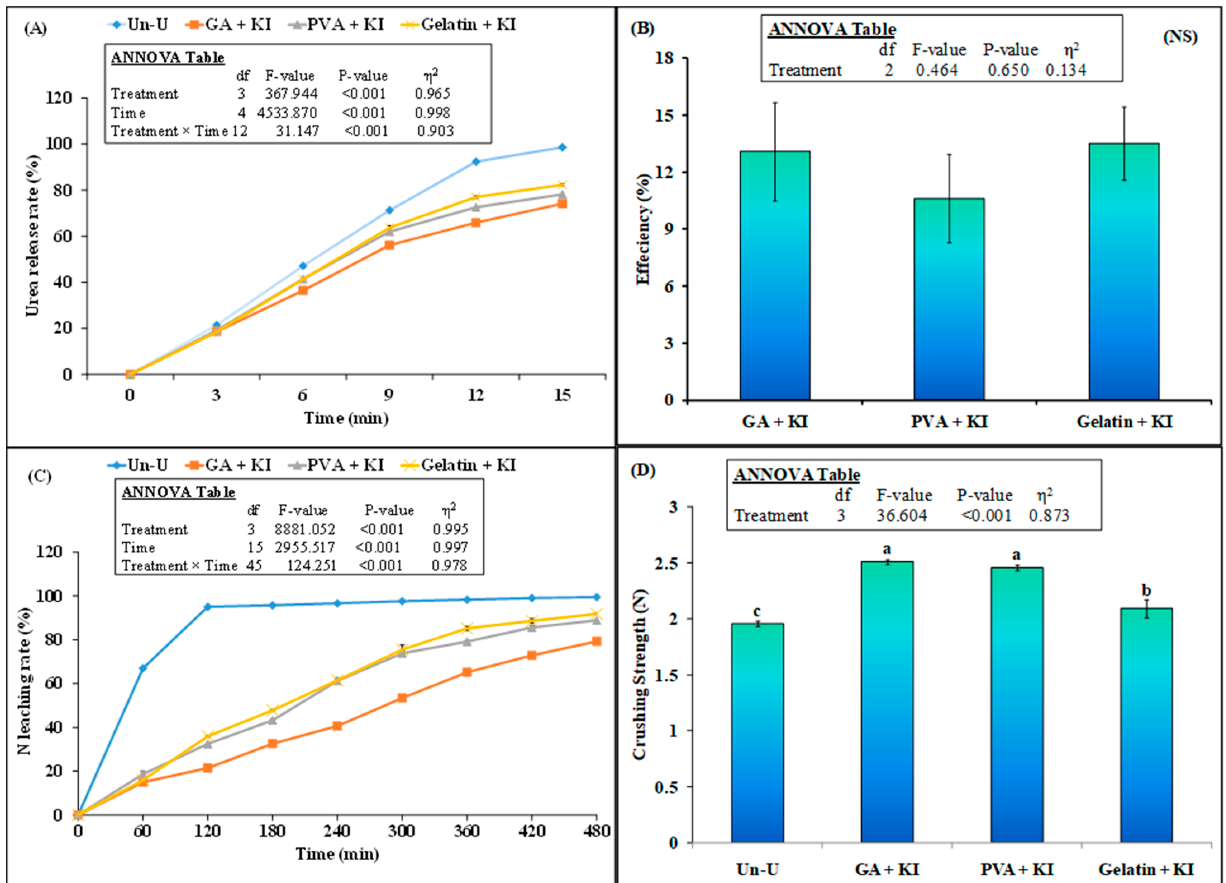
Figure 3. Mean (n = 3) urea release ( A ), urea release efficiency ( B ), N leaching rate ( C ), and crushing strength ( D ) of granular urea. Abbreviations of fertilizer treatments are presented in Figure 1. Error bars show standard errors (±1 SE) of the mean. Different small letters in figure D illustrate significant differences among treatments at a 5% probability level after the Tukey ‐ HSD test. The inset table representes the outcomes of the analysis of variance (ANOVA).